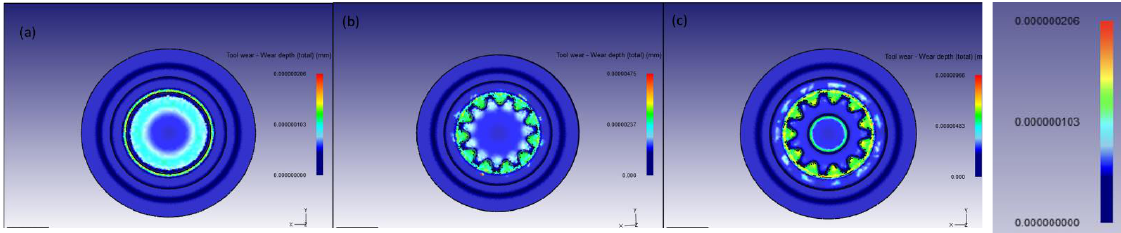
Figure 23. Comparison of wear depth pattern in mm: ( a ) Actual top die, ( b ) Top die with the teeth, ( c ) Top die with a punch hole.